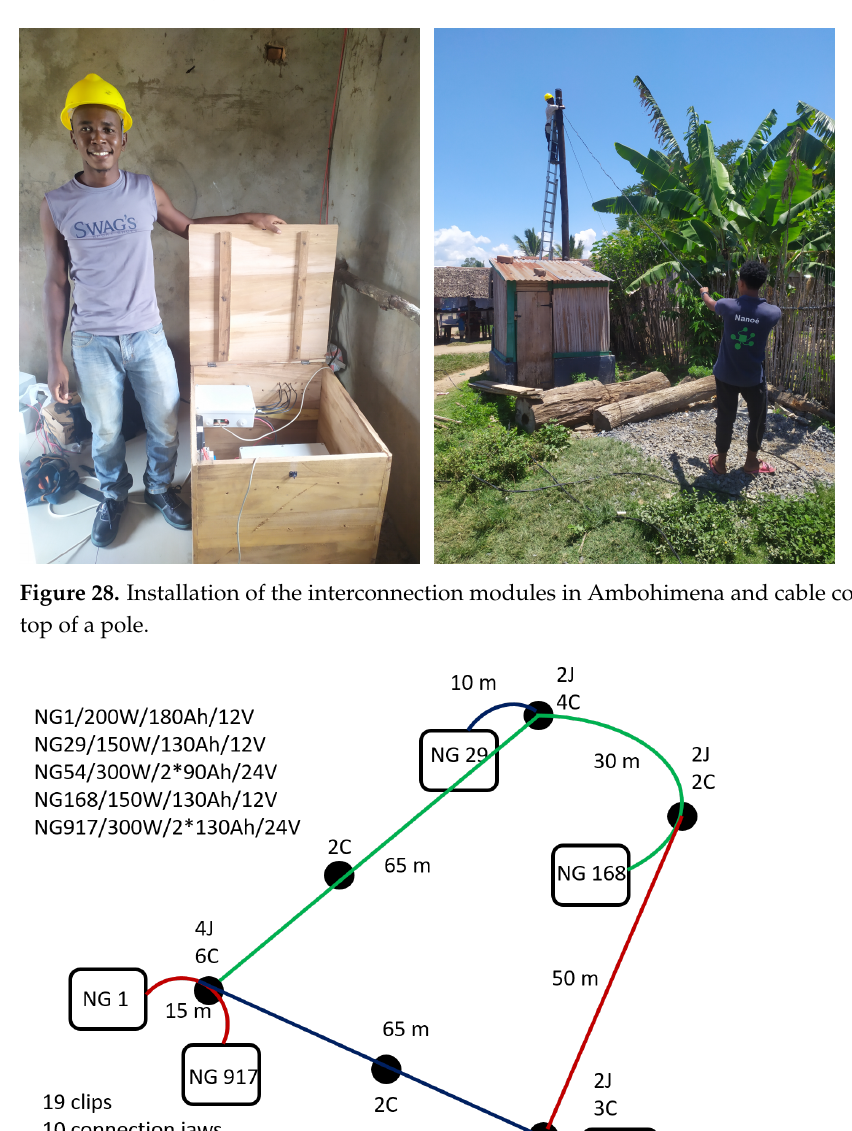
Figure 27. Local mounting of the interconnection modules and cable set-up in Ambohimena. Three days of labor were needed to install the interconnection modules, the wooden poles and the electric cables, as shown in Figures 27 and 28. The schematic of the installation is presented in Figure 29. For the installation, 16 mm² cables were used.